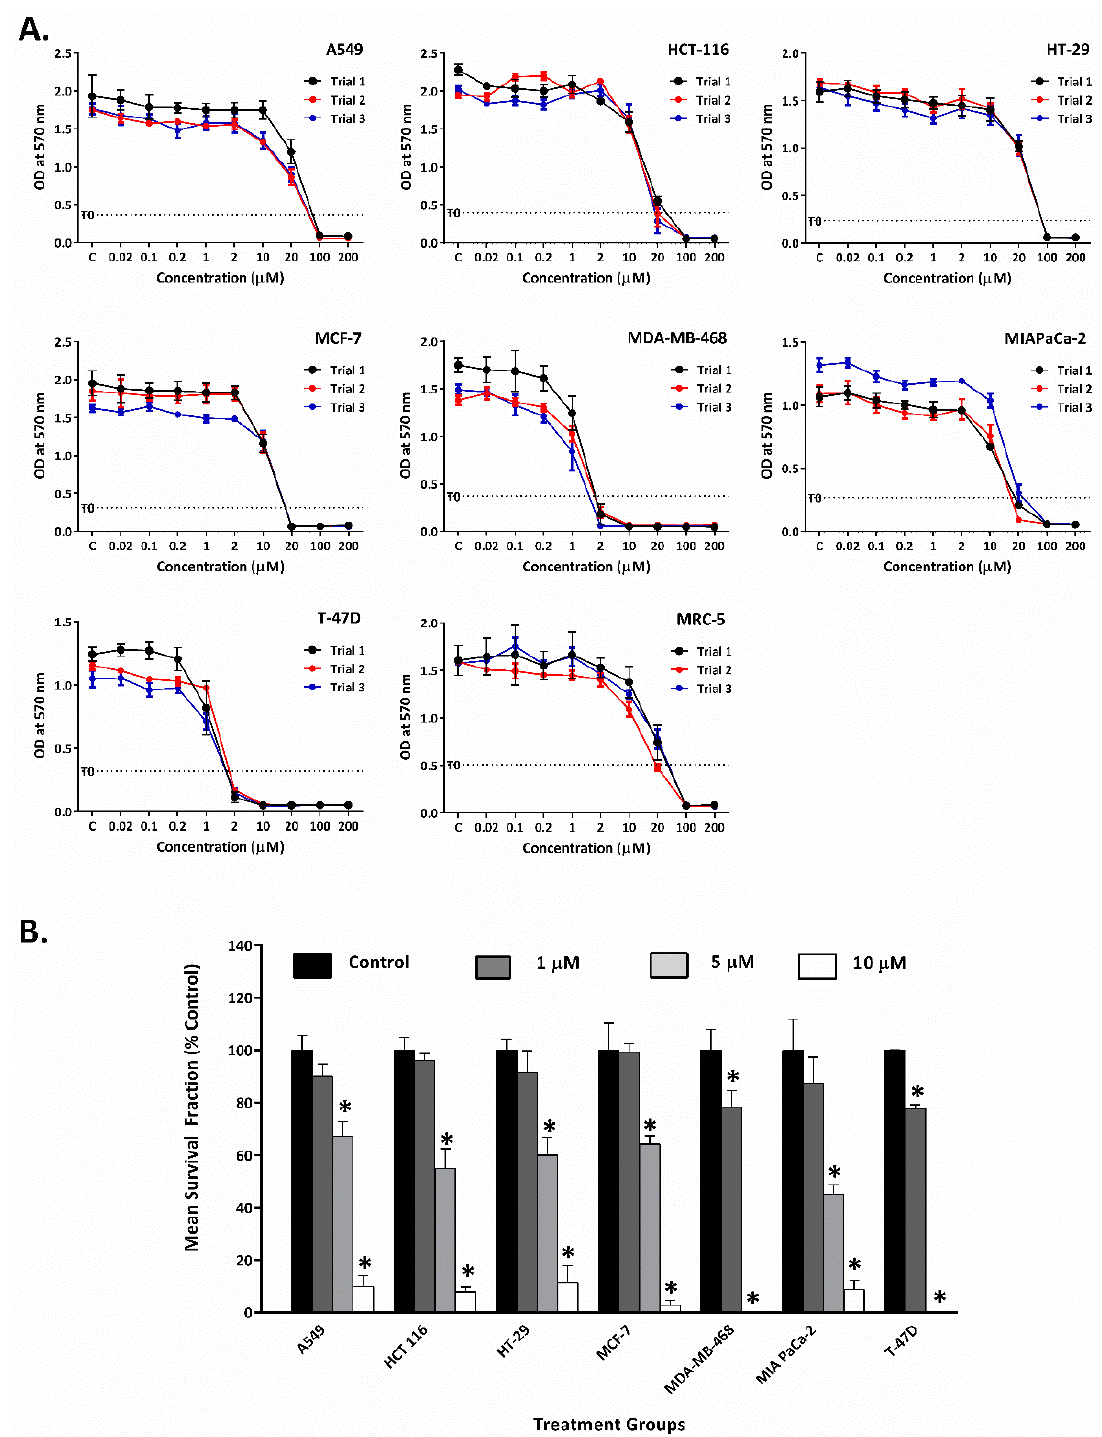
Figure 2. ( A ). Line graphs show TQ’s growth-inhibitory effects on A549, HCT-116, HT-29, MCF-7, MDA-MB-468, MIAPaCa-2, T-47D, and MRC-5. Each graph shows three independent MTT trials. For each graph, the T 0 value is the average of three trials. Cells were seeded in 96-well plates (3 × 10 3 cells/well) and treated with TQ for 72 h. No. trials ≥ 3; n = 4 per independent experiment. ( B ). Mean ± SD bars show TQ’s inhibition of A549, HCT 116, HT-29, MCF-7, MDA-MB-468, MIAPaCa-2, and T-47D colonies. Data presented as mean survival fraction as % of control. Asterisk indicates significant inhibition ( p ≤ 0.05). Cells were seeded, treated with TQ (24 h), and then medium was replaced. When colonies contained ≥50 cells in control wells, colonies were fixed, stained, and counted. Plating efficiencies ranged between 20 and 35%. No. trials ≥3; n = 2 per independent trial.